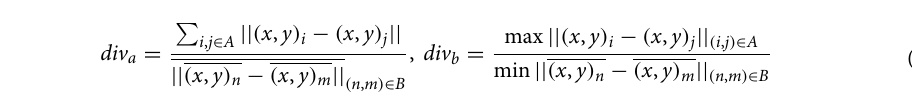
Fig. 4d,f show fitted surfaces of each 5 min annealed structure surface images from AFM (Fig. 4d) and SEM (Fig. 4f). In addition to the surface fitting coefficients, mean deviation of the fitted surface from the true surface also exhibited an annealing time-dependent trend, as shown in the grey columns of Fig. 5c. For structures up to annealing time of 60 min, the surface profiles exhibited a definite sinusoidal trend. On the other hand, the